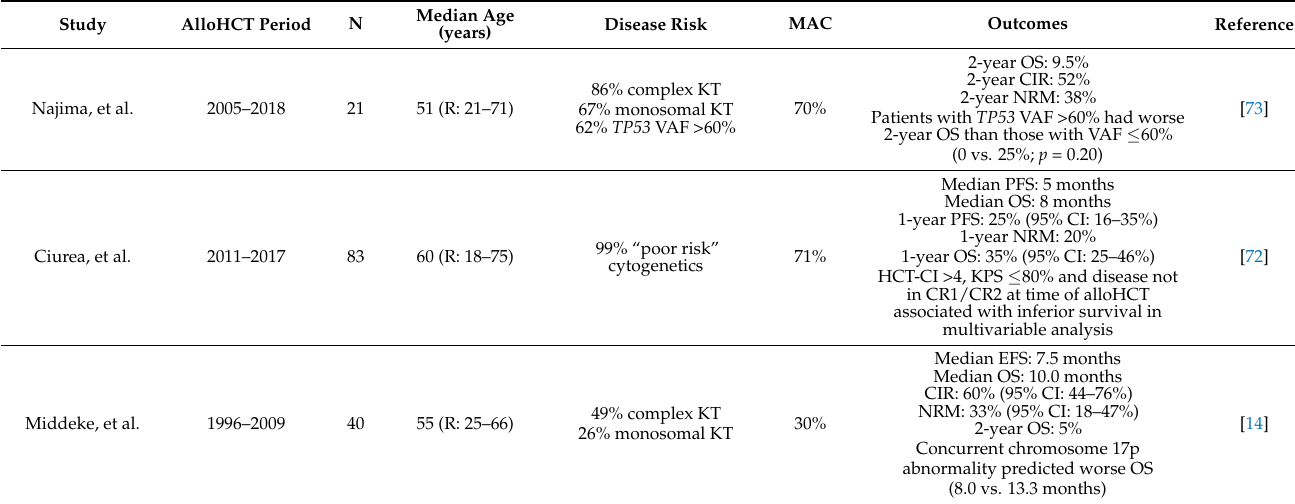
Table 3. Summary of experience with allogeneic hematopoietic stem cell transplantation for TP53 -mutated acute myeloid leukemia.